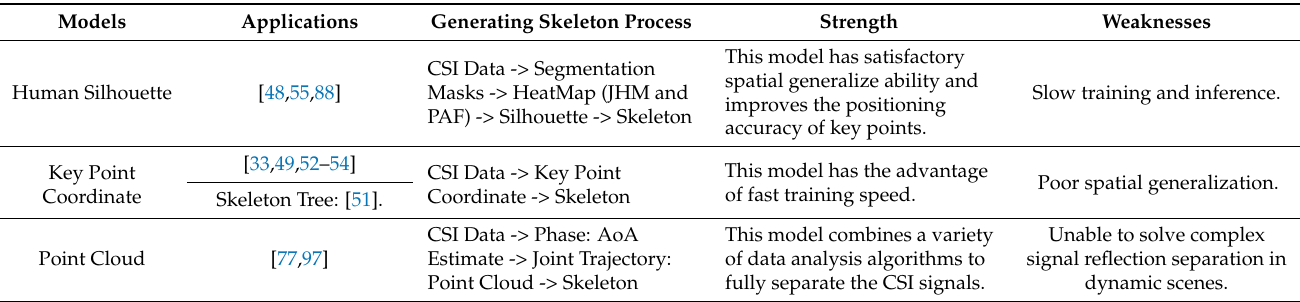
Table 6. Typical Models of Generating Human Skeleton.